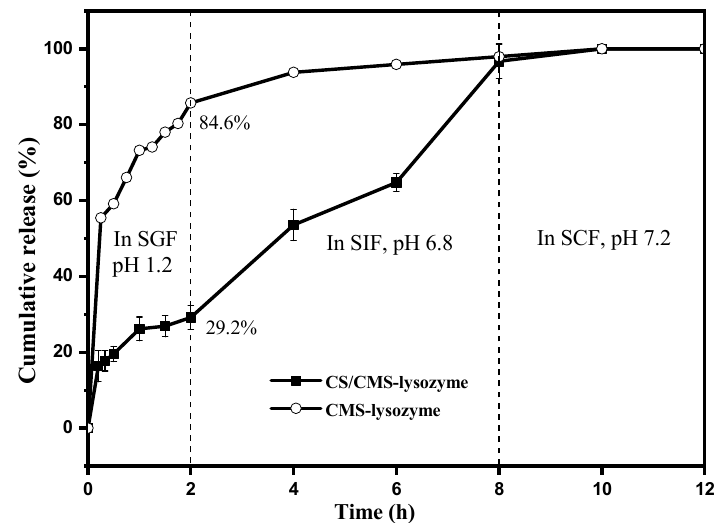
Figure 6. In vitro releasing kinetics of lysozyme from stabilized microspheres under stimulated digestive fluids. Bars represent the corresponding standard deviations ( n = 3).